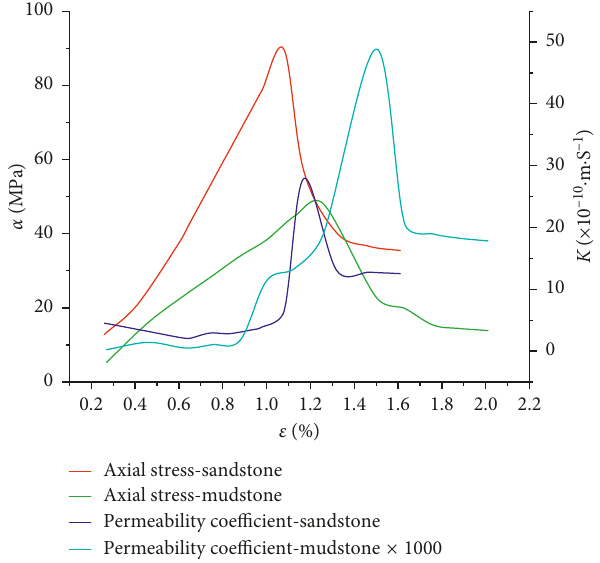
Figure 7: The relationship curve for the rock strength and per- meability coefficient with the strain of the intact